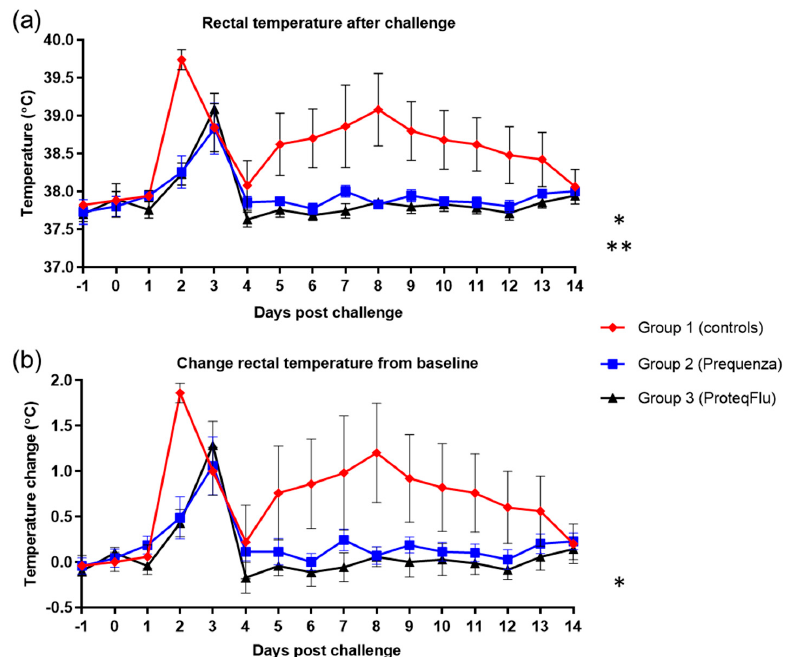
Figure 5. ( a ) Rectal temperature and ( b ) change of the rectal temperature from baseline in groups 1–3 after challenge with H3N8 A/equi-2/Wexford/14 (FC2 sublineage). Red diamond = group 1, unvaccinated control group; blue square = group 2, Equilis Prequenza-vaccinated group; black ProteqFlu-vaccinated group. Error bars represent SEM. Inferential statistics: significant difference triangle = group 3, ProteqFlu-vaccinated group. Error bars represent SEM. Inferential statistics: ( p < 0.05) between groups 1 and 2 (*) and groups 1 and 3 (**) (mean effect between 1 and 14 significant difference ( p < 0.05) between groups 1 and 2 (*) and groups 1 and 3 (**) (mean effect